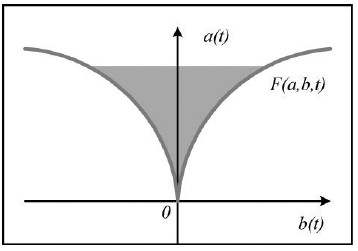
Figure 3. Coming out of the dotted area borders means the indication of